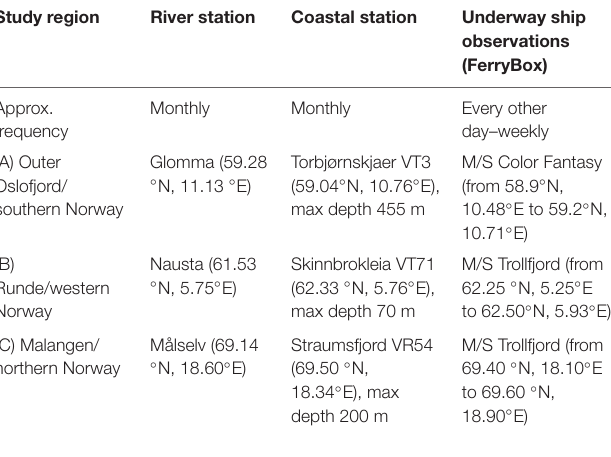
TABLE 1 | Overview of study regions, with corresponding stations and relevant data sources. Study region River